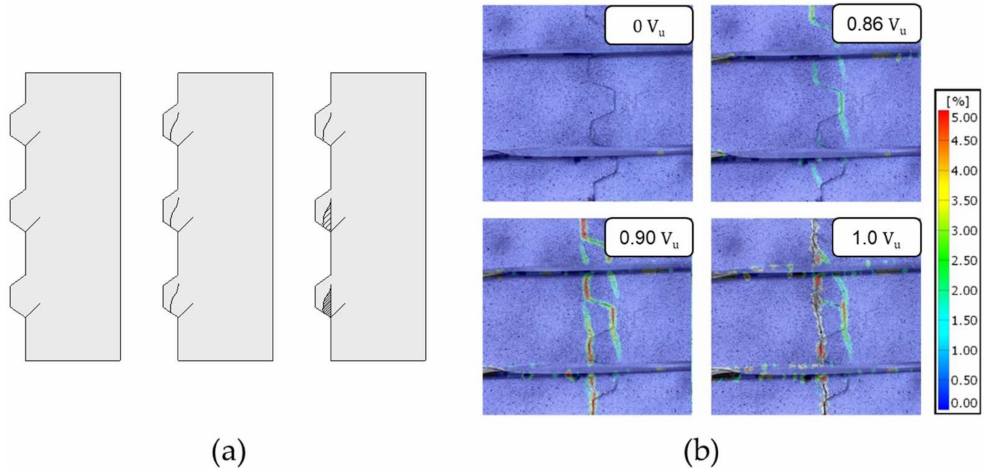
Figure 19. ( a ) Crack model of the three-keyed dry joints of Jiang et al. [30] and ( b ) crack pattern of the specimen